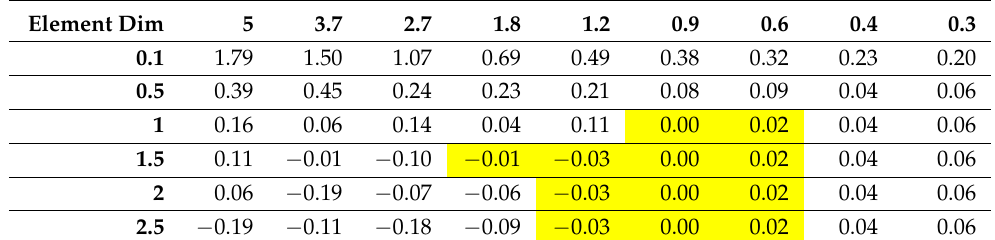
Table 10. The comparison between the dimension of the superficial and the volumetric element for the retopologised models with the adaptive size parameter set to 30. The columns represent the size of the quadrangular mesh elements, while the rows represent the size of the volumetric ones.